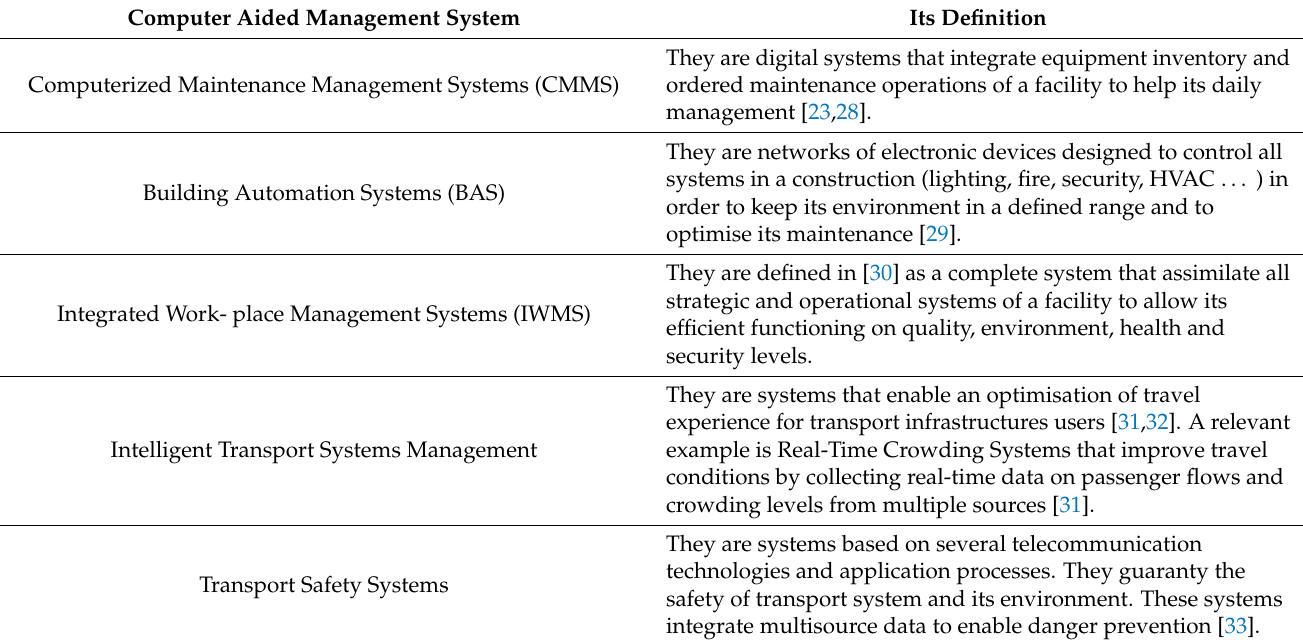
Table 1. Examples of Computer Aided Management Systems for Transport Infrastructures. Computer Aided Management